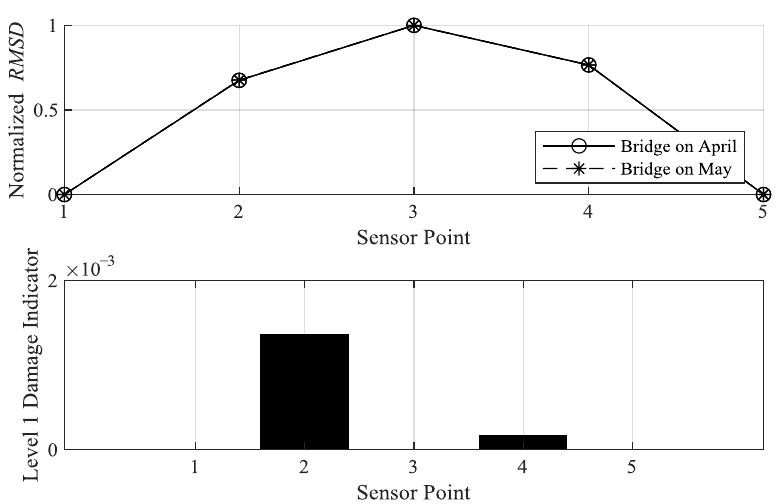
Figure 27. Calculated fundamental frequencies for each set of data.